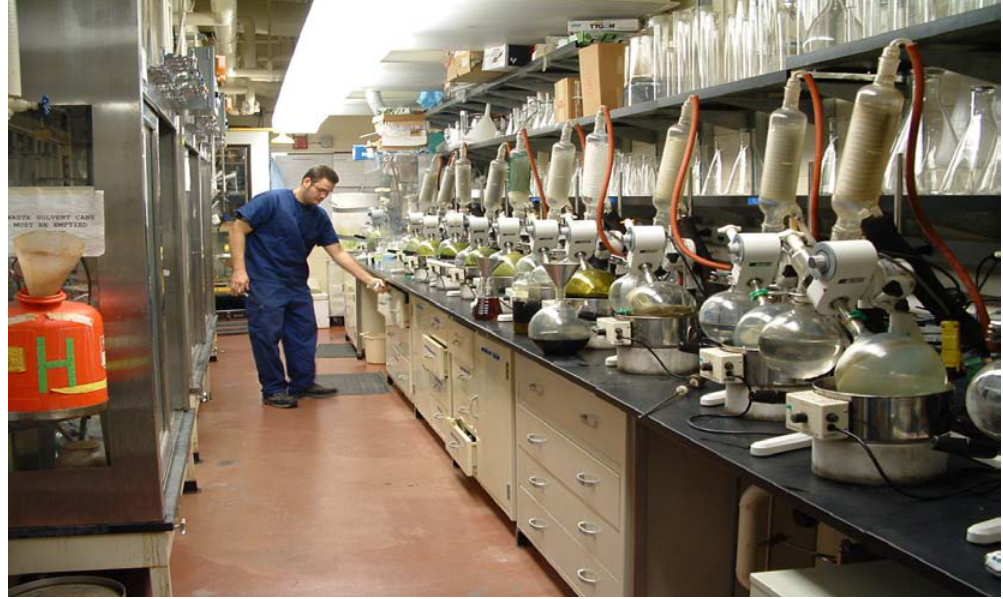
Figure 7. A 12-unit manifold of rotary evaporators. All glass is plastic safety coated. Note the stainless steel steam ducts in the rotovaps and stainless steel funnels.